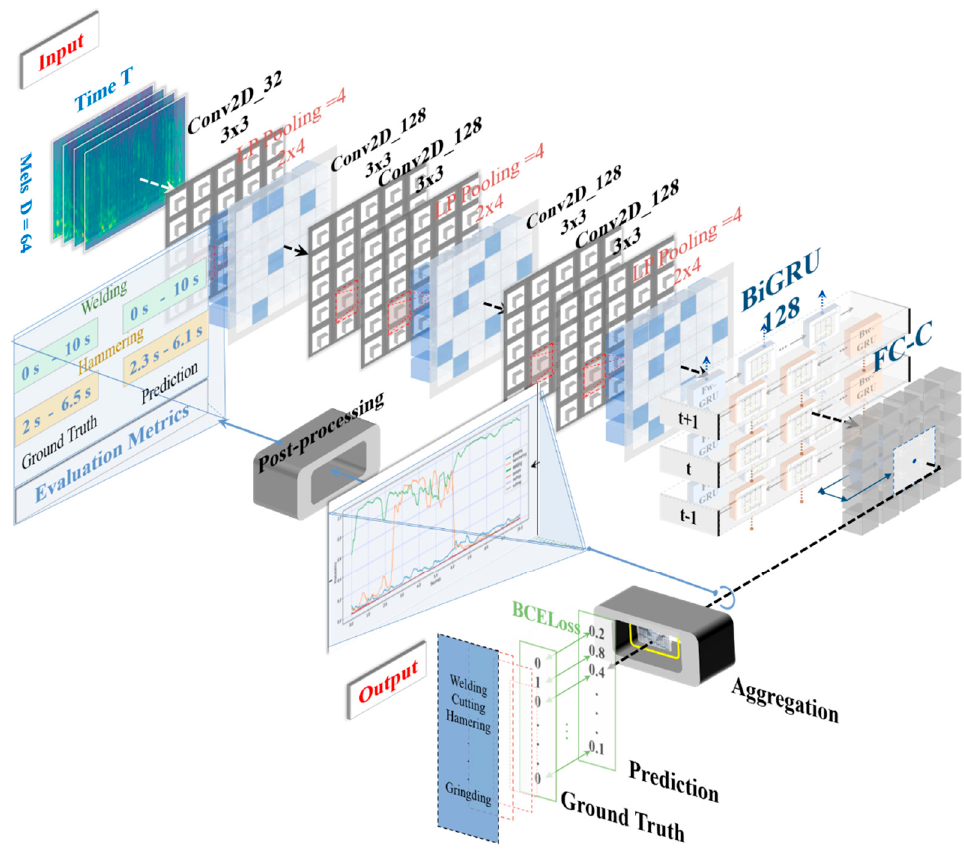
Figure 5. Structure of proposed CRNN model.